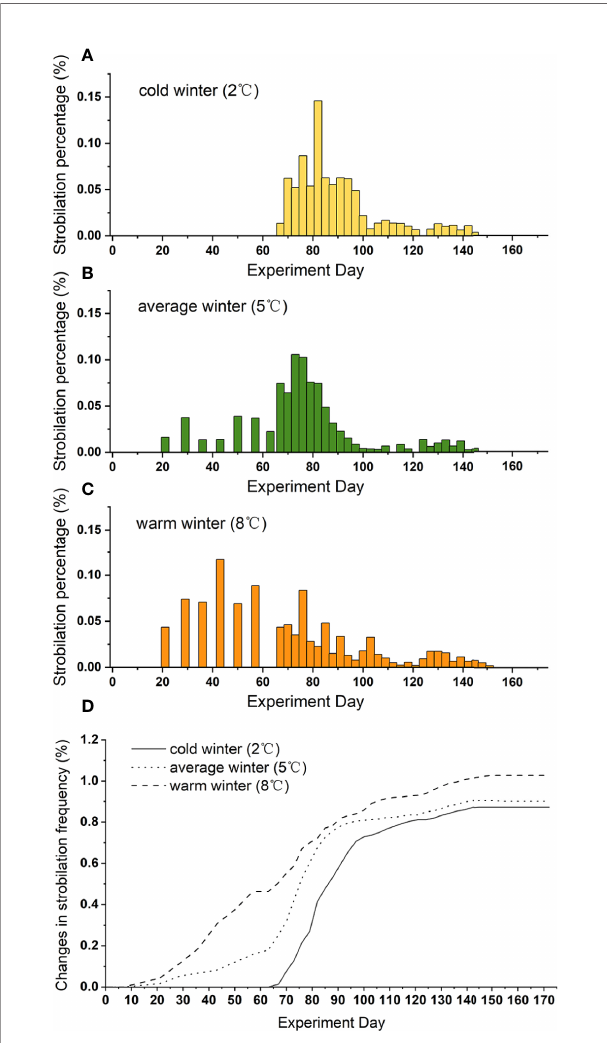
FIGURE 3 | Strobilation percentage with time at different winter temperatures [2°C (A) , 5°C (B) , and 8°C (C) ] and change in strobilation frequency at 3 winter temperatures (D) . During the winter period, records were made every 7 days, and during the warming period, records were made every 3 days.